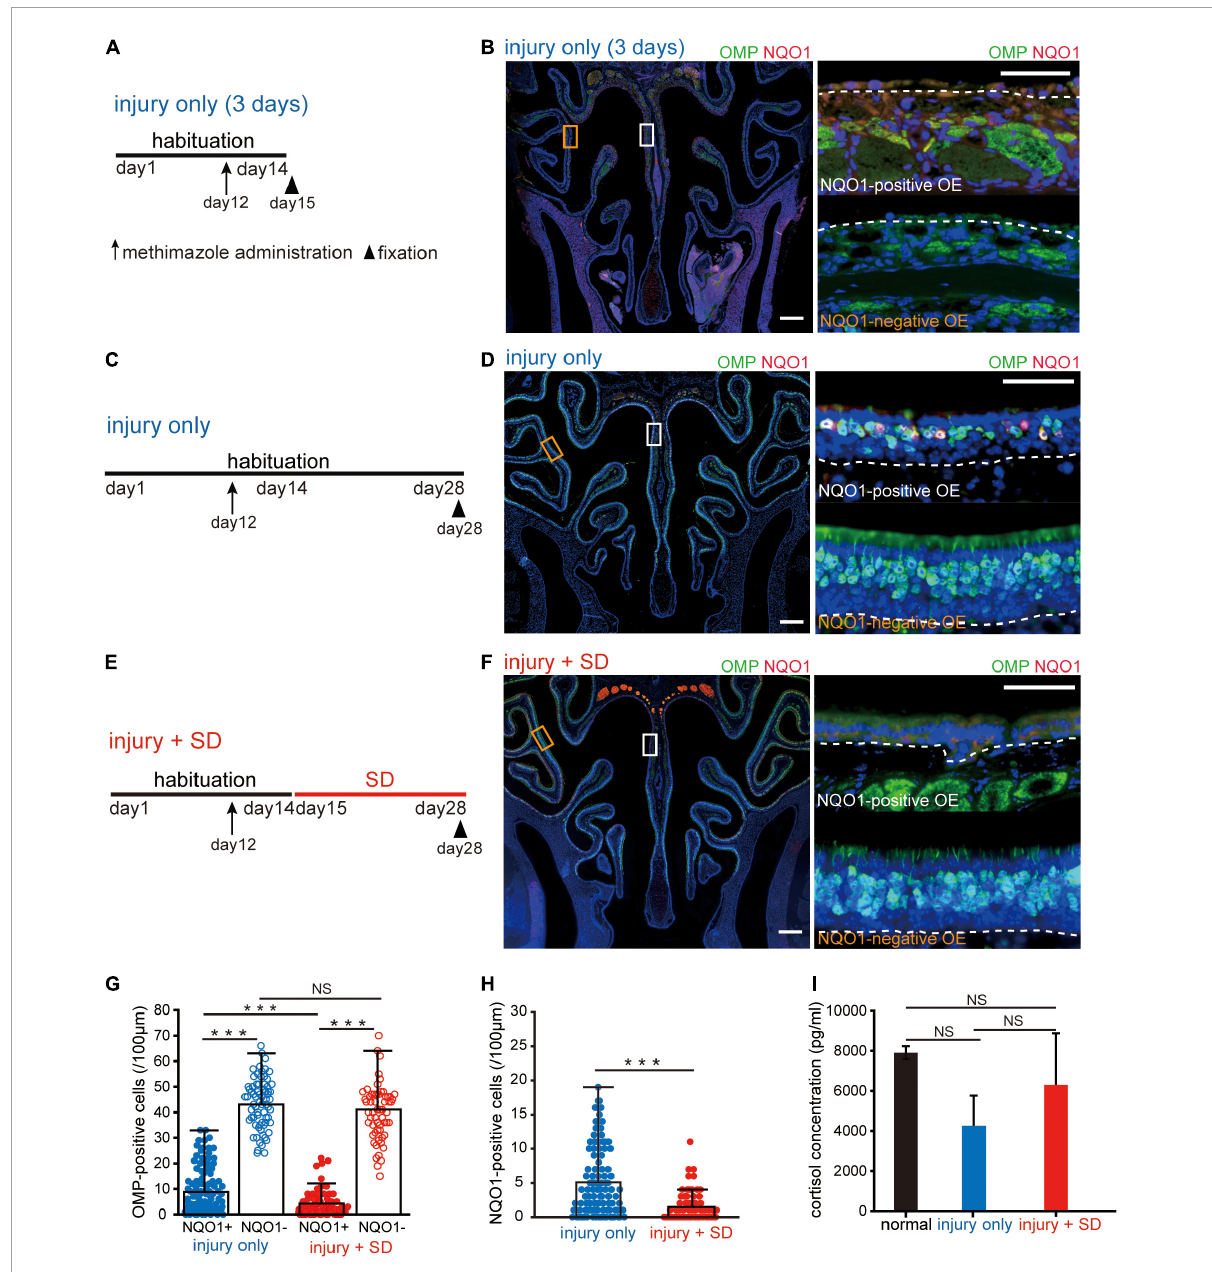
FIGURE3 Short-term sleep deprivation selectively induces delayed regeneration in the NADPH quinone oxido-reductase 1 (NQO1)-positive olfactory epithelium (OE) following injury. (A) Time course and experimental design. Methimazole was administered on day 12, and perfusion with a fixative was conducted on day 15. Arrow indicates the timing of methimazole administration, and arrowhead indicates the timing of fixation. (B) Photomicrographs of representative coronal sections captured 3 days after methimazole administration (injury only, 3 days). Pictures on the right show higher magnification images captured from the areas indicated by the squares on the left picture (upper, NQO1-positive OE; lower, NQO1-negative OE). The dashed line represents the basement membrane of the OE. Scale: 300 µ m at low magnification, 50 µ m at high magnification. (C) Time course and experimental design. Methimazole was administered on day 12, and perfusion with a fixative was performed on day 28. (D) Photomicrographs of representative coronal sections at 16 days following methimazole administration (injury only). Pictures on the right show higher magnification images captured from the areas indicated by the squares on the left picture (upper, NQO1-positive OE; lower, NQO1-negative OE). Scale: 300 µ m at low magnification, 50 µ m at high magnification. (E) Time course and experimental design. Methimazole was administered at day 12 (arrow) after starting habituation. Three days after methimazole administration, a 2-week SD was initiated, and fixation was conducted on day 28 (arrowhead). (F) Photomicrographs of representative coronal sections following methimazole-induced injury and sleep deprivation (injury + SD). Pictures on the right show higher magnification images captured from the areas indicated by the squares on the left picture (upper, NQO1-positive OE; lower, NQO1-negative OE). Scale: 300 µ m at low magnification, 50 µ m at high magnification. (G) Counts of olfactory marker protein (OMP)-positive cells of NQO1-positive (NQO1+) and NQO1-negative